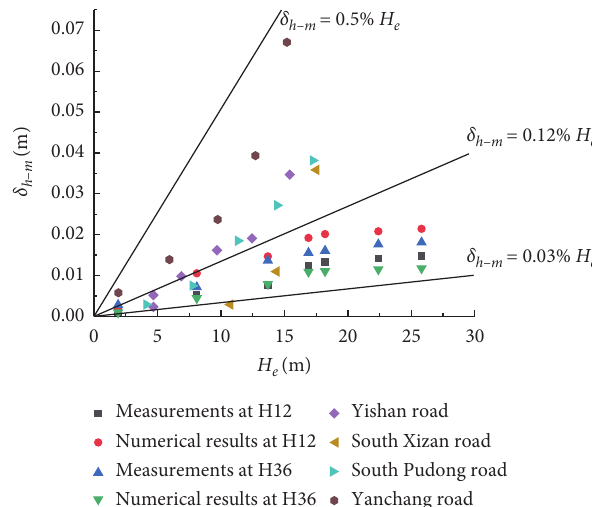
Figure 14: The relationship between the maximum lateral de- formation ( δ h − m ) and the excavation depth ( H e ) in this study and other cases.